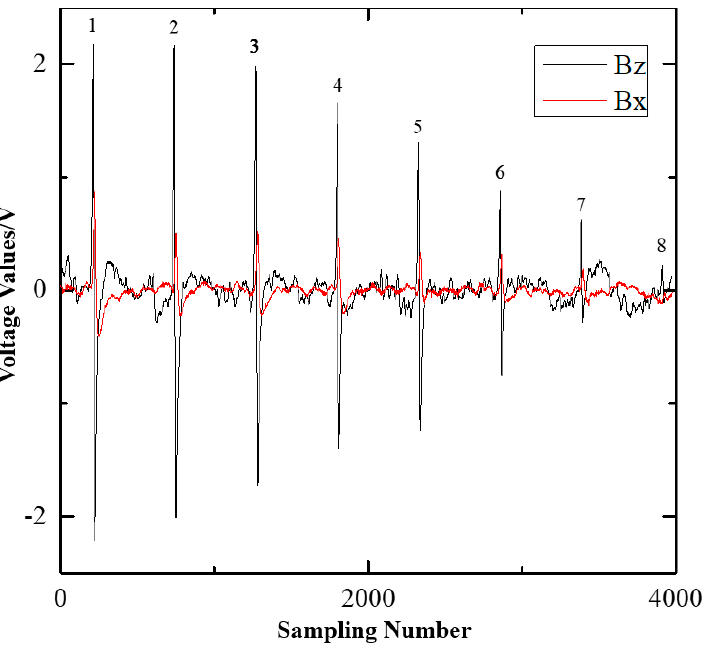
Figure 12. The sensor signal at di ff erent depths.